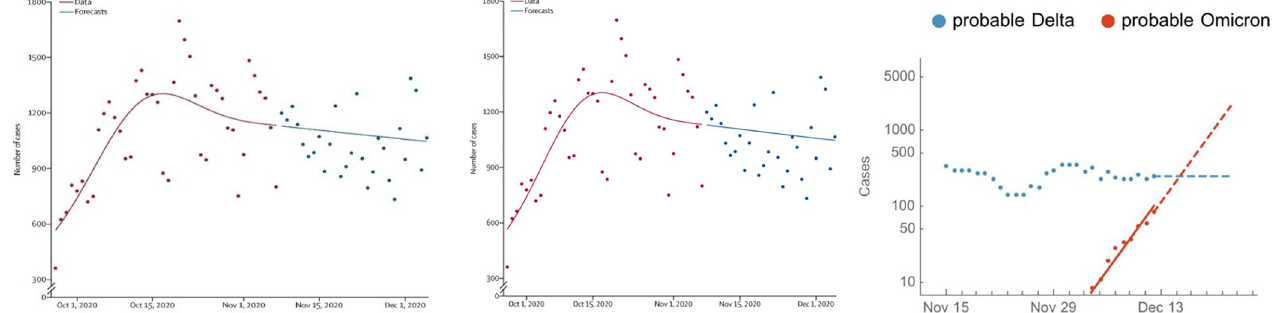
Fig 6. Predictions based on RNNCON-Res (a) Shows total probable COVID-19 cases based on ground truth (b) Shows probable Omicron and Delta variant cases.